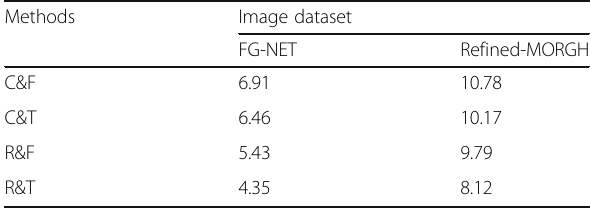
Table 4 MAE results of FG-NET dataset